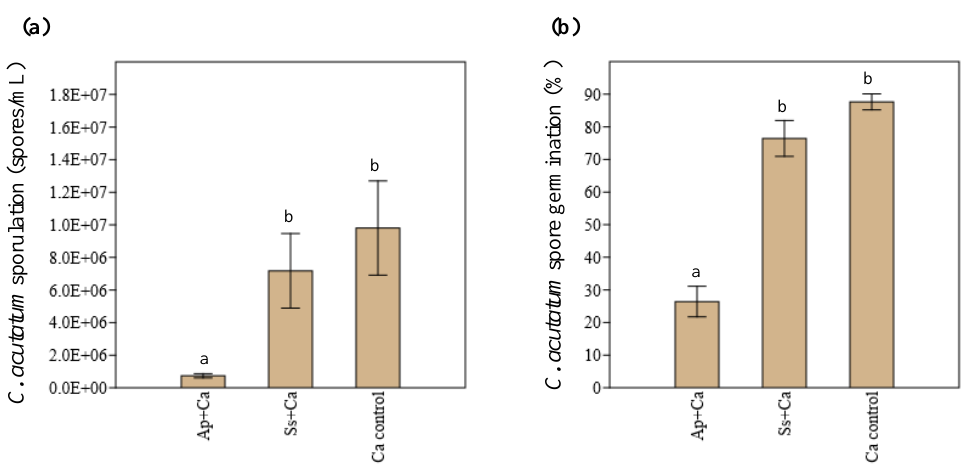
Figure 4. Sporulation ( a ) and spore germination ( b ) of Colletotrichum acutatum in the presence of the endophytes Aureobasidium pullulans (Ap + Ca) and Sarocladium summerbellii (Ss + Ca) and in control ( C. acutatum — Ca control), in olive bioassays, after 21 days of pathogen inoculation. Bars with different lowercase letters indicate significant differences ( p < 0.05, n = 5).